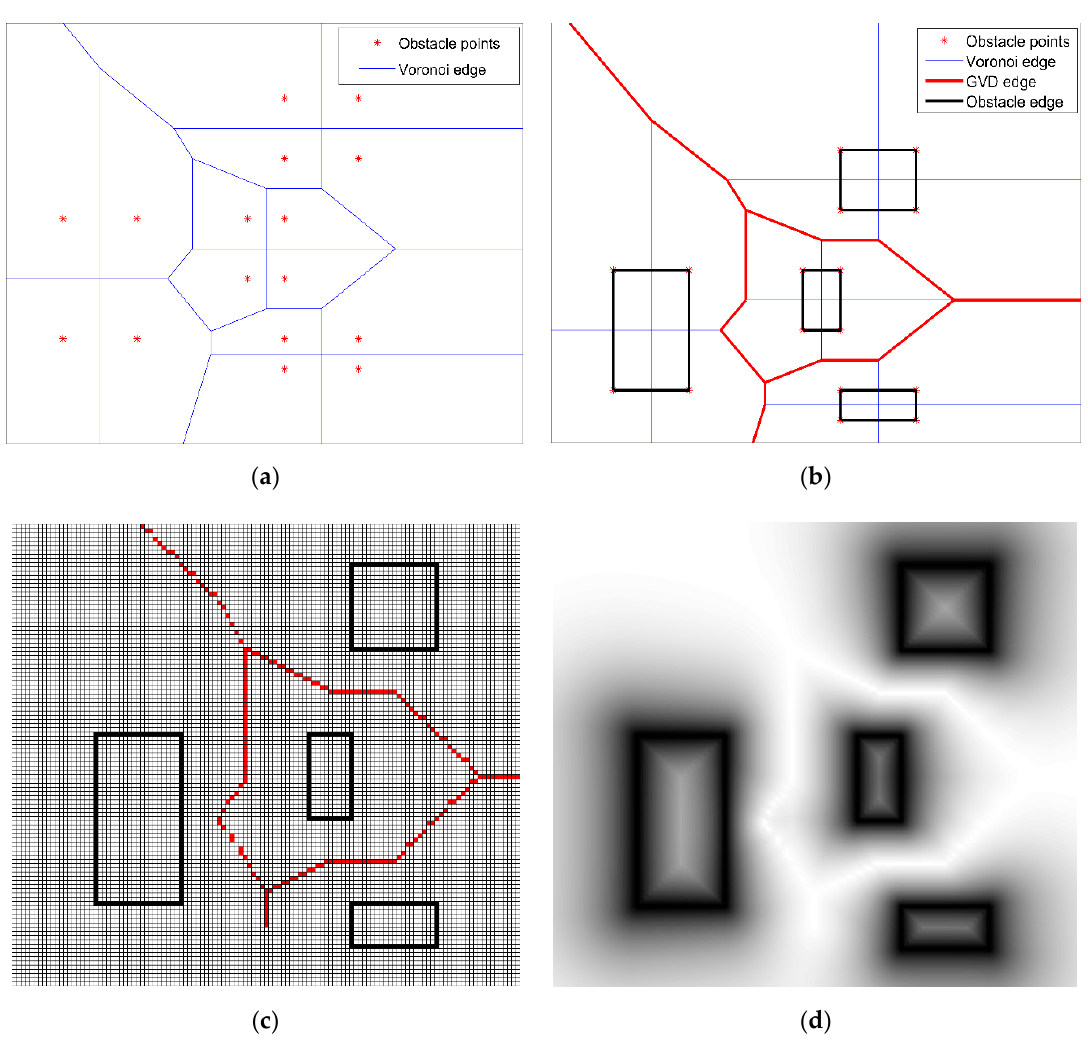
Figure 6. Schematic diagram of Obstacle Cost Map generation. ( a ) is the original Voronoi diagram; ( b ) is the GVD; ( c ) is the grid form of GVD; ( d ) is the Obstacle Cost Map, the black color represents the obstacle grid and the white represents the Voronoi edge.